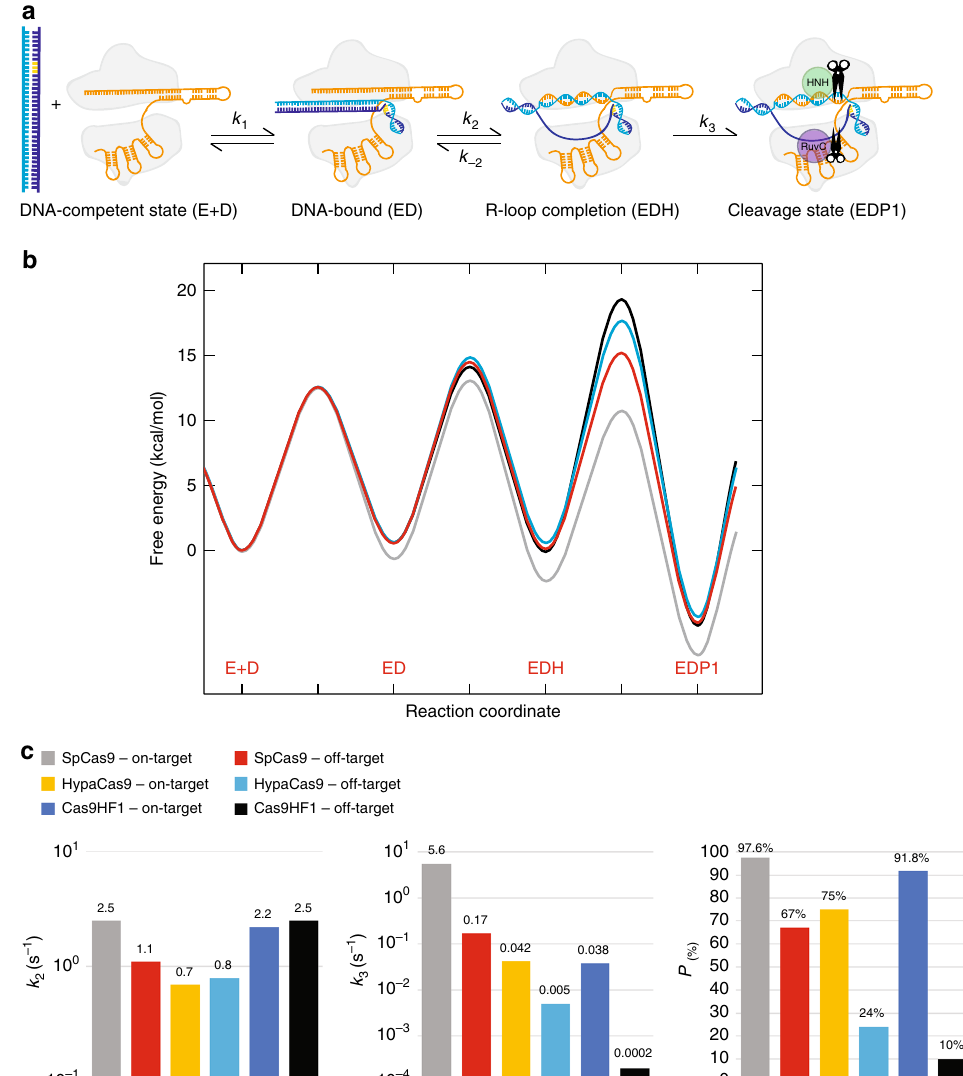
Fig. 7 Speci fi city is governed by the kinetic partitioning of Cas9. a Cartoon representation of Cas9 enzymes reaction pathway. b Free energy pro fi les for SpCas9 cleavage of an on-target (gray line) from Gong et al. 15 and off-target (red line), respectively; HypaCas9 cleavage of an off-target (blue line); and Cas9-HF1 cleavage of an off-target (black line). Each pro fi le was calculated using transition state theory using rate and equilibrium constants that were derived from globally fi tting each set of experiments (Table 1). Note the higher barriers for DNA cleavage relative to the lower barrier for the preceding reverse reaction increase the probability of DNA release. c Summary bar graph for k 2 , k 3 , and kinetic partitioning